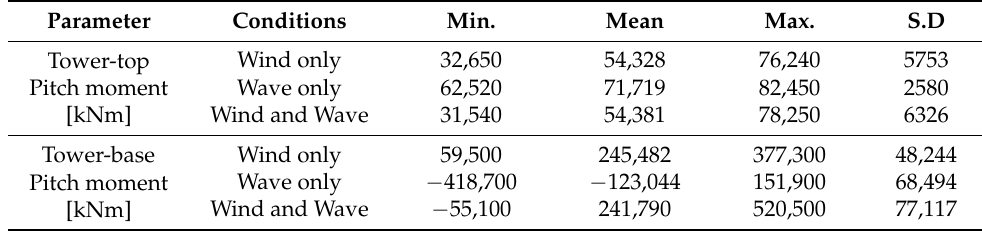
Table 4. Statistical values of tower-top and tower-base pitch moments.